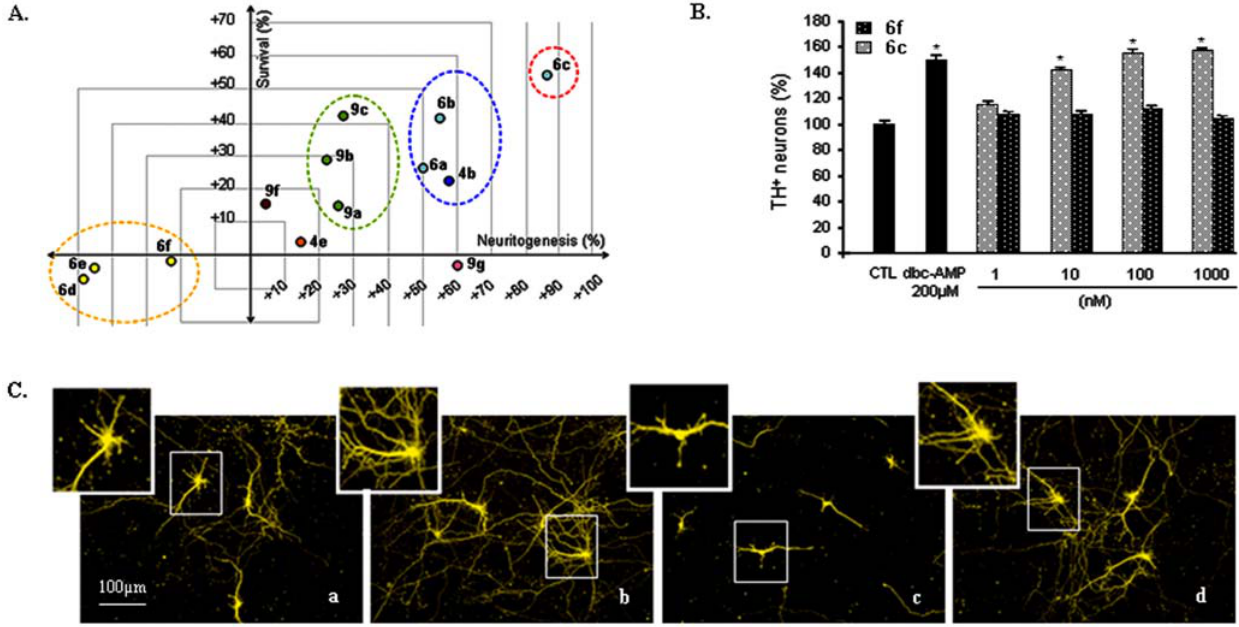
Figure 2. Screening for both neuroprotective and neuritogenic activity on DA neurons. (A) Two-dimensional representation of Table 1 showing four main groups of compounds exhibiting or not both neuroprotective and neuritogenic activity in different ratios. (B) The substitution position of the lateral chain is crucial for both activities ( 6c vs. 6f ). 2-substituted compounds induced an increase in both TH neuron survival and neuritogenesis in a dose-dependent manner, while 3-substituted compounds inhibited both activities. Dbc-AMP at 200 m M was used as a positive control. Values are normalized to the non-treated control (CTL) and represent the average of at least three assays realized in triplicate and are expressed as mean 6 SEM. *P , 0.001. Statistical analysis was performed by one-way ANOVA followed by Bonferroni’s post hoc test. (C) Compound 6c (b) increased the number and the length of DA neuron processes compared to non-treated cultures (a). In contrast, neuritogenesis of DA neurons in compound 6f -treated cultures (c) was slowed down, showing the crucial role of the substitution position on the combined activity. (b) and (c) represent (tyrosine hydroxylase) TH immunolabeled neurons in cultures treated with 100 nM of compounds 6c and 6f . A dose-dependent neuritogenic effect was also observed for compound 6c (data not shown), while compound 6f was still inactive at higher concentrations (data not shown). Dbc-AMP at 200 m M (d) was used as a positive control. Images were acquired with an inverted fluorescent microscope coupled to a digital